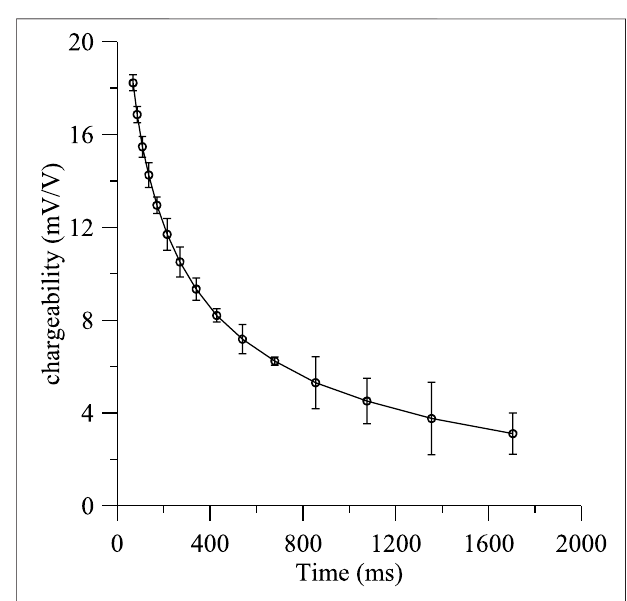
FIGURE 6 | Observed chargeability curve and error bars at point D10. The maximum value of error bar is 1.55%.